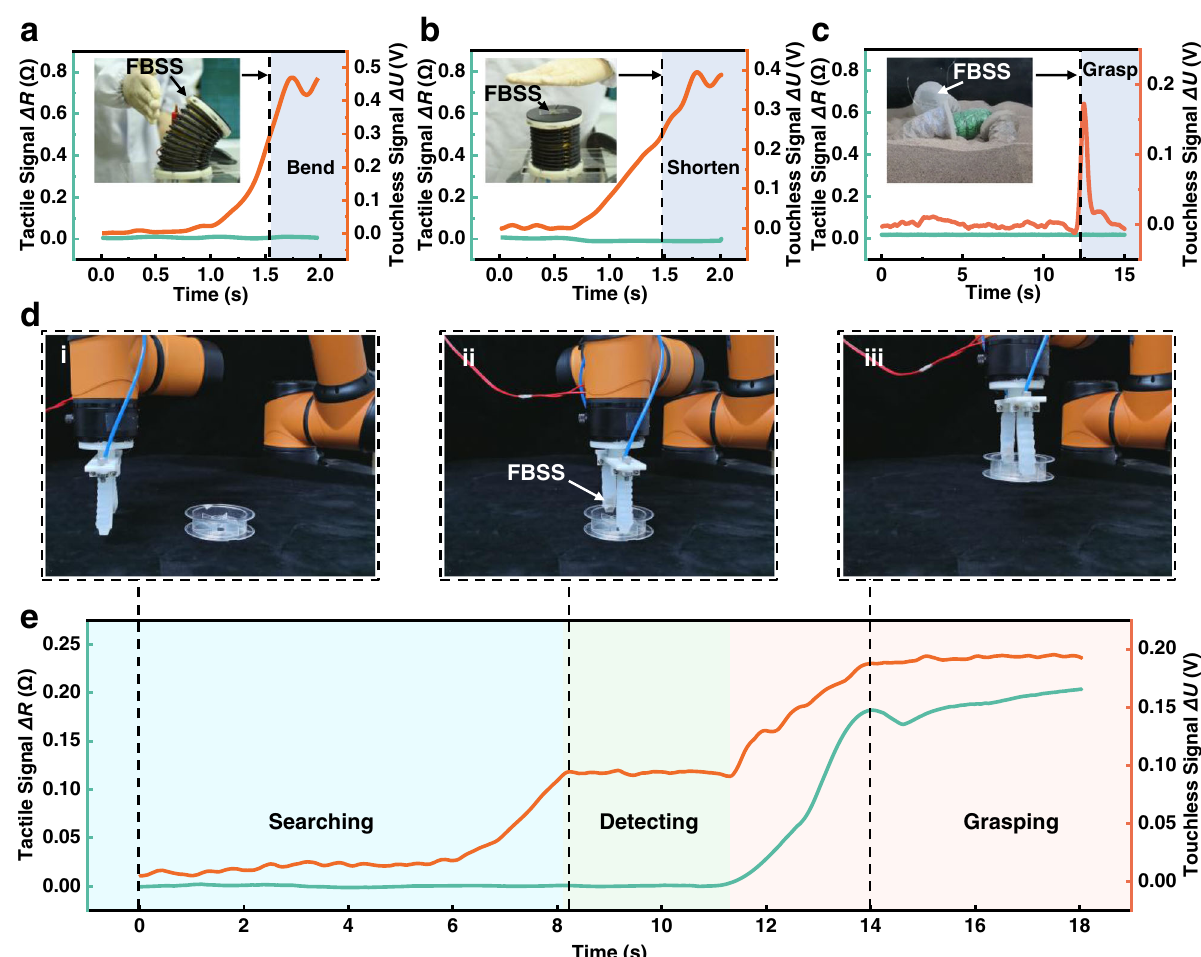
Fig. 4 | Self-reacting soft robots triggered by touchless external stimuli from human and environment. Touchless control of a pneumatic-actuated 3 DoFs soft manipulatorfor a bending and b shortening in response to anapproaching human hand. c Apneumatic-actuatedsoftorigamirobotwiththeFBSSsuccessfullydetects and grasps a toy bug. d Demonstrating a soft robotic gripper equipped with the